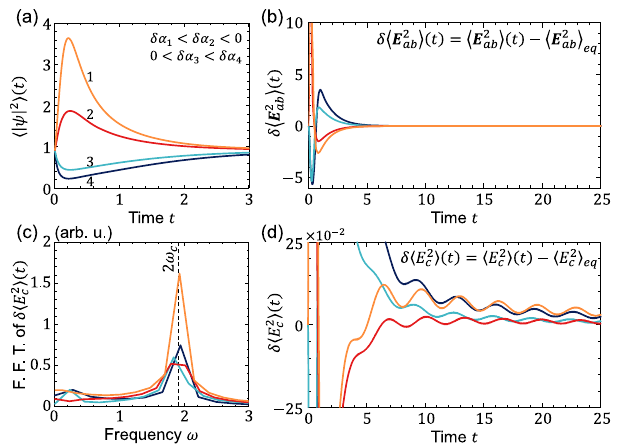
Fig. 4 Photoexcitation dynamics in anisotropic superconductors in the pseudogap phase above T c . a Evolution of 〈 ∣ ψ ∣ 2 〉 ( t ) looks overdamped regardless of the quenching conditions. b Similarly, the in-plane electric fi eld also displays overdamped dynamics due to the large in-plane plasmon gap ω ab ≫ ω c . c , d In contrast, the out-of-plane electric fi eld variance exhibits oscillations with frequency 2 ω c ( d ), as shown in F.F.T. analysis in ( c ). These oscillations are long-lived because the out-of-plane normal conductivity σ c is small. Parameters used: τ = 5, τ E = 10 − 2 , τ α = 0.1, χ − 1 = 0, κ